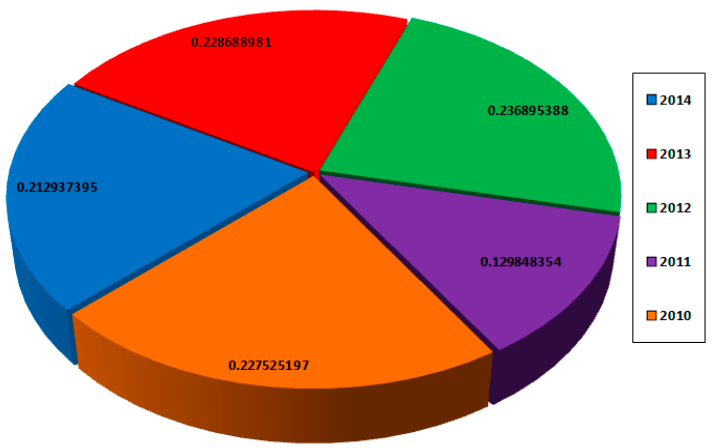
Figure 10. Electrical power output in the south coast of the Atlantic (MW).